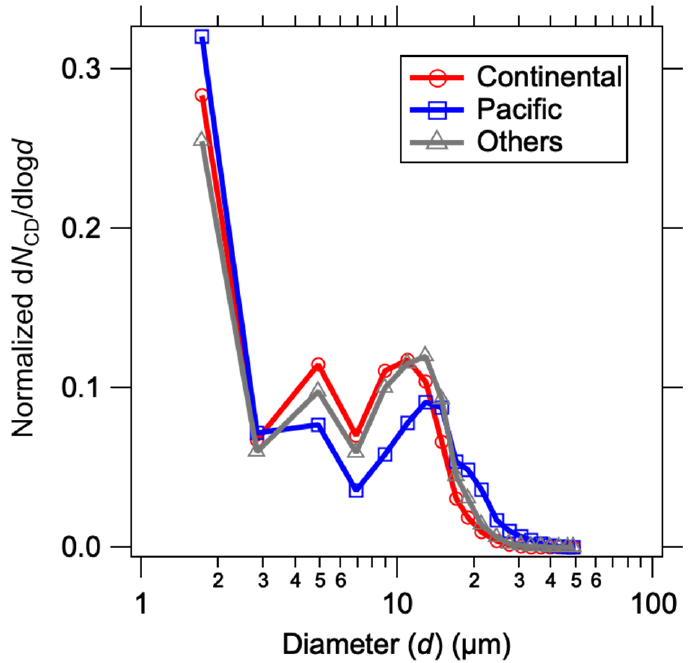
Figure 9. Normalized number size distribution of the cloud droplets at the MFRS classified according to air mass origins.